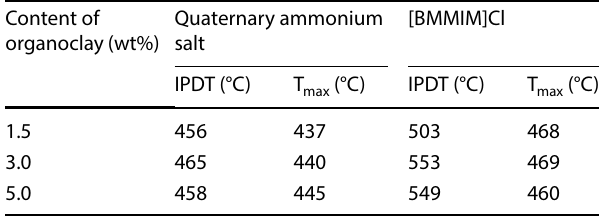
) obtained by the PP- max